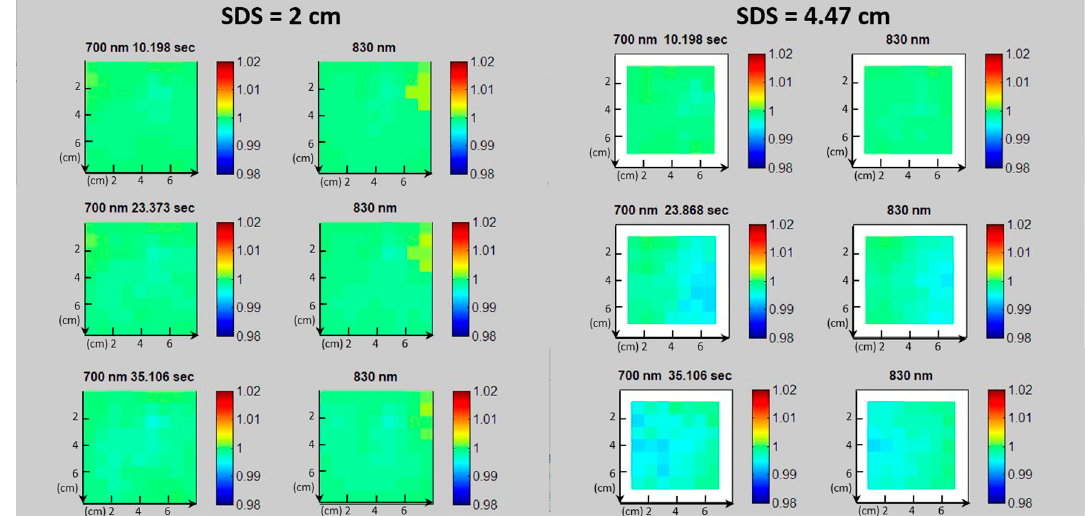
Figure 9. Back-projection images reporting the normalized photocurrents after 700 nm and 830 nm irradiation, related to three different instants for 2 cm and 4.47 cm SDSs.